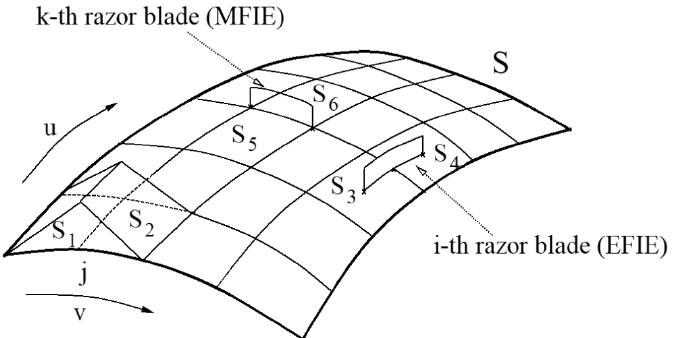
Figure 1. Basis and testing functions defined as curved rooftops and razor blades on a NURBS (non- uniform rational B-spline) patch.